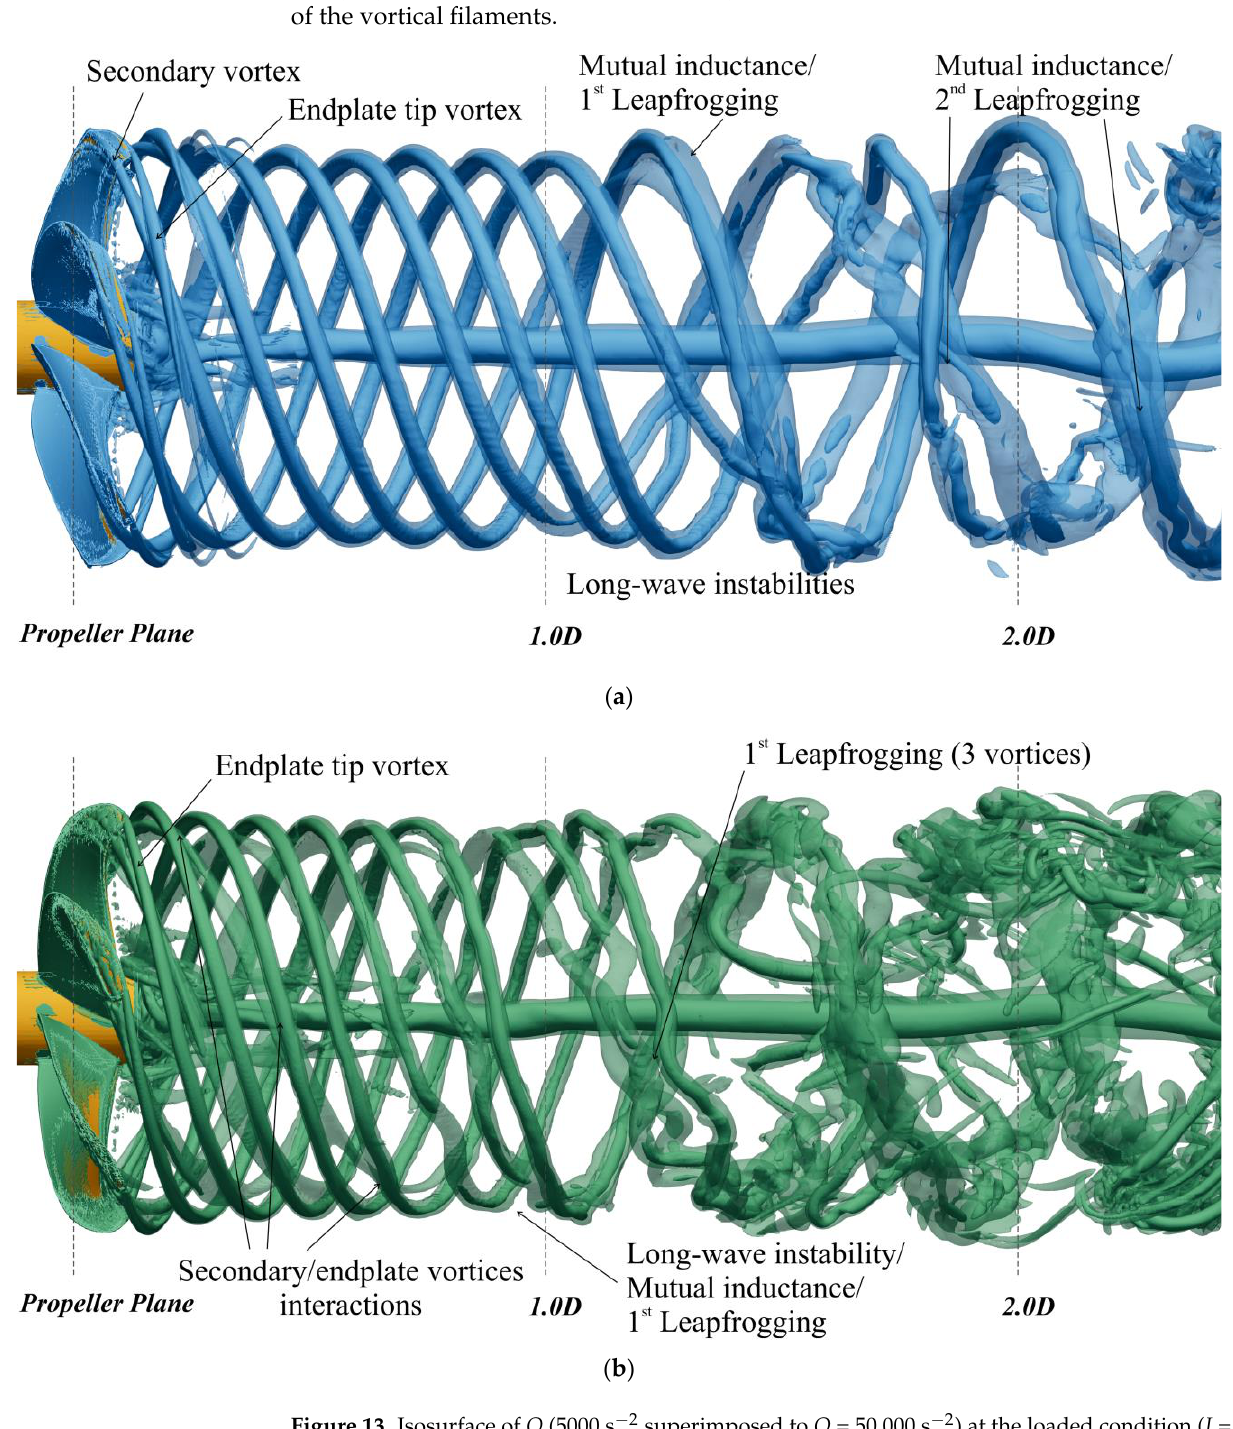
Figure 13. Isosurface of Q (5000 s −2 superimposed to Q = 50,000 s −2 ) at the loaded condition ( J = 0.6). Details. ( a ) Conventional CLT propeller; ( b ) New generation CLT